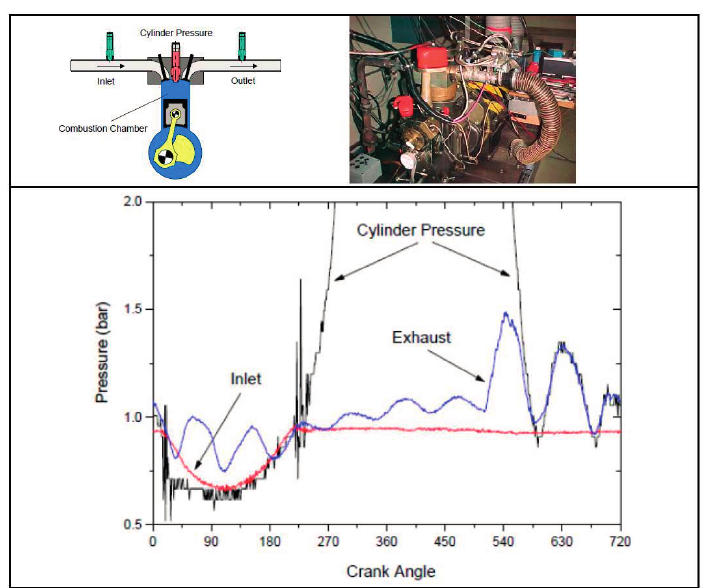
Figure 13. Test results with the fabricated sensor as inlet and exhaust sensor in combustion engine in compare with reference sensor